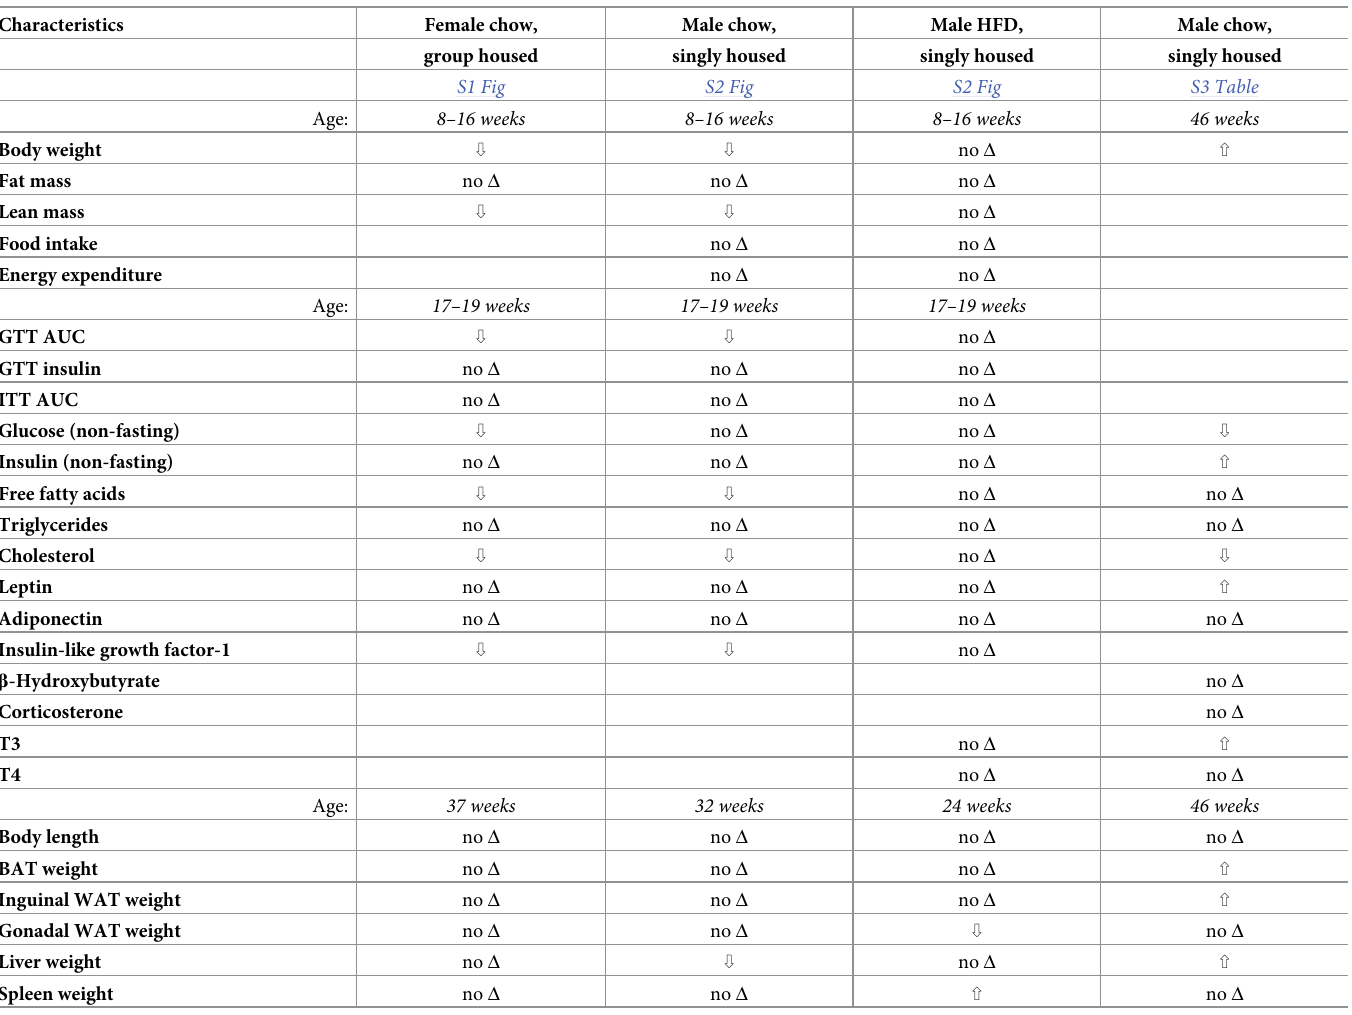
Primary data are in S1 Fig, S2 Fig, and S3 Table. Arrows indicate significant changes (without multiplicity correction) in the indicated direction of the QKO mice; no Δ indicates no significant change. Abbreviations: AUC, area under the curve; BAT, interscapular brown adipose tissue; GTT, glucose tolerance test; HFD, high-fat